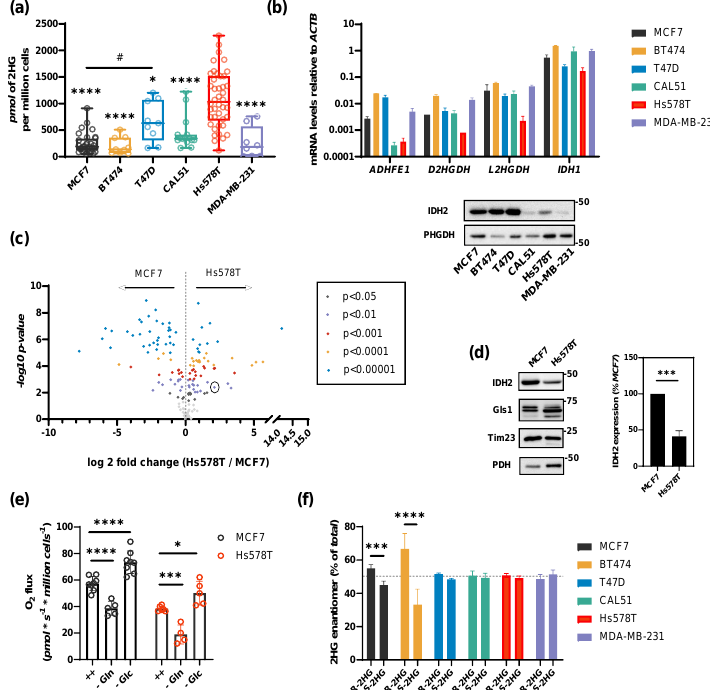
Figure 1. 2HG production in breast cancer cells. ( a ) Box plots of 2HG production in breast cancer cell lines. n > 8. # p < 0.05 MCF7 vs. T47D. One-way ANOVA. ( b ) Quantification of the expression level of genes/proteins related to 2HG production measured by qPCR or western blot. ( c ) Volcano plot of polar metabolites in MCF7 and Hs578T cells. 2HG is indicated by the circle. ( d ) Comparison of IDH2 levels in MCF7 and Hs578T cells. n > 3. t -test. ( e ) Respiration of MCF7 and Hs578T cells in glucose and glutamine-free media, respectively. n > 5. Two-way ANOVA. ( f ) Percent of R- and S-enantiomers of 2HG in breast cancer cell lines. n > 3. Two-way ANOVA. * p < 0.05, *** p < 0.001, **** p <